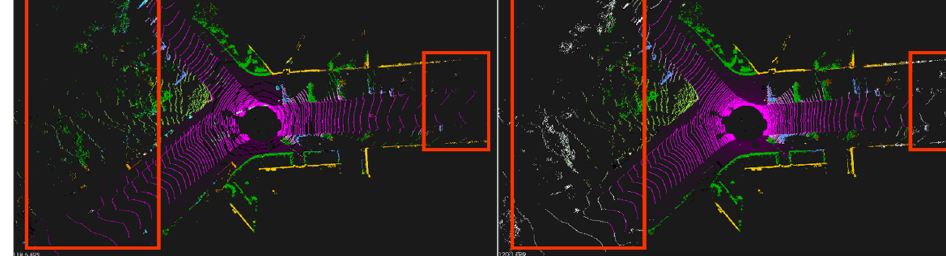
Figure 11. Network result.